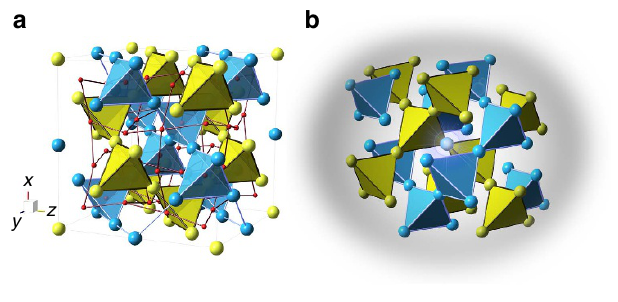
Figure 1 | Pyrochlore structure of Yb 2 þ x Ti 2 (cid:2) x O 7 þ d . Excess Yb 3 þ ion can occupy a Ti 4 þ site and create a local defect (referred to as ‘stuffing’). ( a ) Representation of the ideal pyrochlore structure of Yb 2 Ti 2 O 7 , with Yb in blue, Ti in yellow and O in red. Yb and Ti form corner-sharing tetrahedra lattices. ( b ) Schematic representation of the structurally distorted environment of a